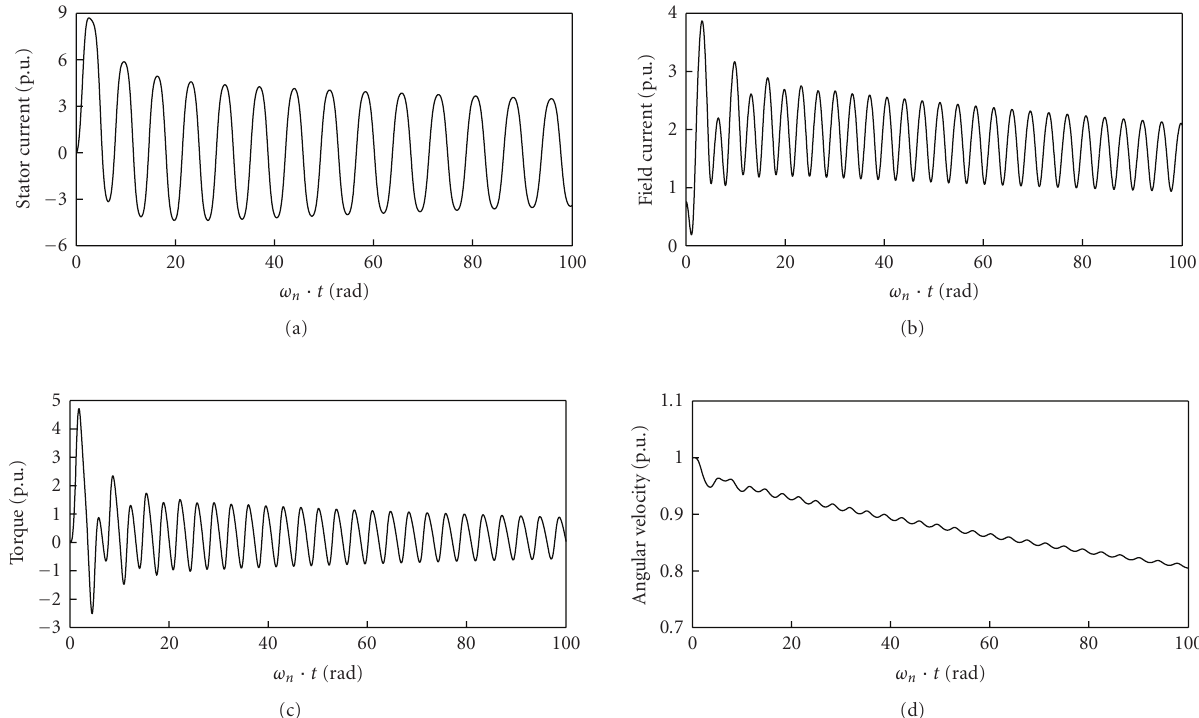
Figure 4: Time-related curves of the characteristic quantities at line-to-ground short circuit for the most unfavorable circumstance: (a) stator phase A current, (b) field current, (c) electromagnetic torque, (d) rotor angular